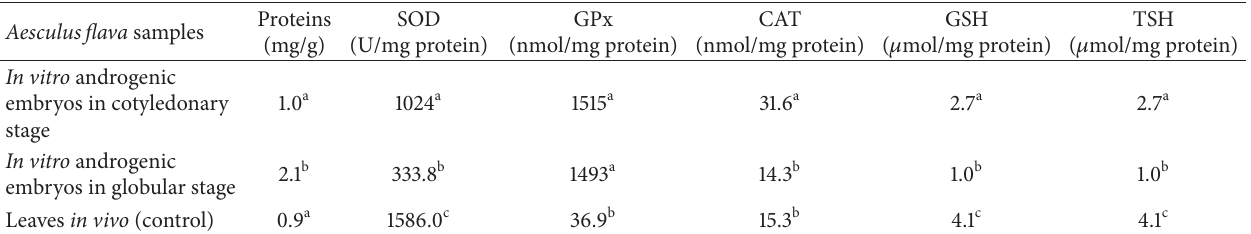
Table 2: Soluble protein content, antioxidant enzyme activities (SOD, GPx and CAT), and glutathione, and total thiol content in A. flava. Proteins Aesculusflava samples In vitro androgenic embryos in cotyledonary stage In vitro androgenic embryos in globular stage Leaves in vivo